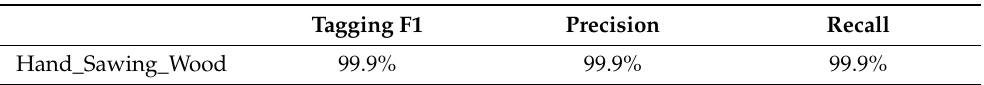
Table 7. The F1-score, precision and recall for extended experiment